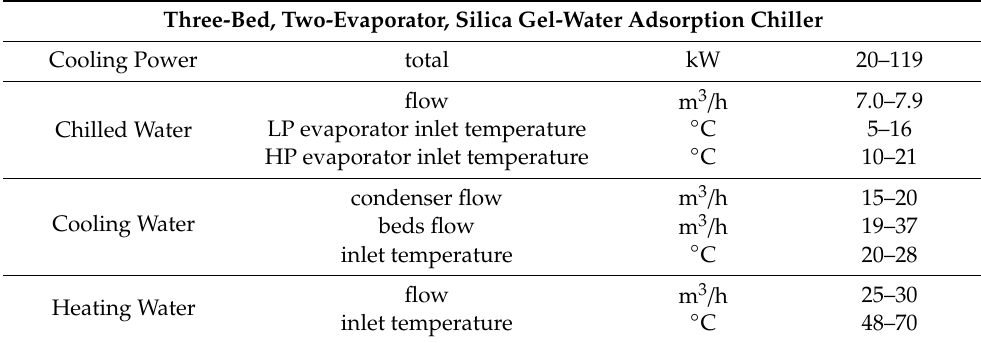
Table 1. Adsorption chiller type and ranges of parameters which the tests were carried out.